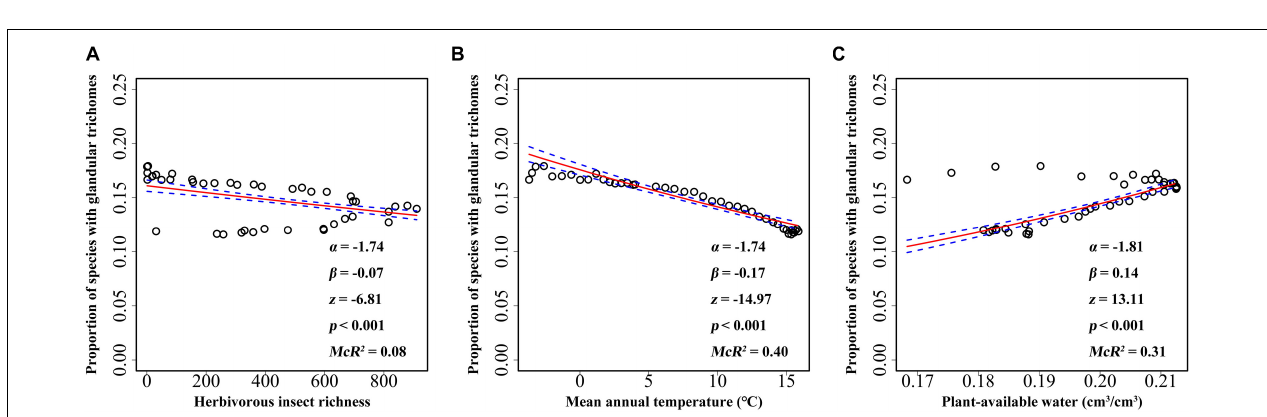
FIGURE 3 | Relationship between elevation and herbivorous insect richness (A) , mean annual temperature (B) , and plant-available water (C) for every 100 m belt in the Hengduan Mountains region. Each point represents the value of herbivorous insect richness or the environmental variable in the corresponding elevation belt. The fitted lines (solid line) and estimated 95% confidence intervals (dashed line) were calculated using regression models that included elevation as both linear and quadratic terms. α and β value was calculated after elevation being scaled.